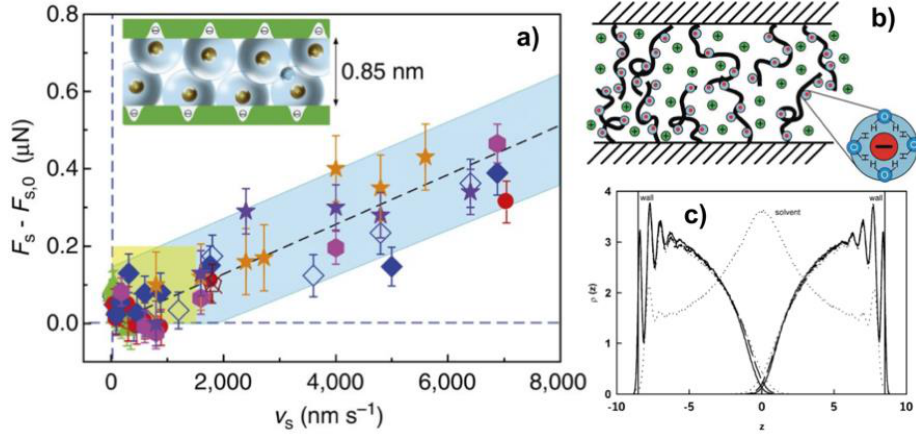
Figure 3. Origins of hydration lubrication. ( a ) The linear variation of the shear force F s with the sliding velocity ( ν s ) characterizes the viscous dissipation via a Newtonian fluid. In this example, ions with their hydration shells are confined between mica surfaces [48]. The inset is approximately to scale and illustrates the filling of the intersurface gap by the hydration water. Different symbols are from different measurements. Full and empty symbols correspond to increasing and decreasing ν s , respectively. From the slope of the blue band an effective viscosity for the confined film η eff = 0.22 ± 0.07 Pa∙s is obtained, which is ~250 times larger than the viscosity of water. This increase does not result from the confinement of water (since the viscosity remains equal to the bulk viscosity [49]) but instead the higher viscous dissipation of the hydration water is associated with the primary hydration shell surrounding the ion. Reprinted by permission from Springer Nature Customer Service Centre GmbH: Nature Research, Nature Communications, Origins of hydration lubrication, Ma, L. et al., (2015). ( b ) Cartoon representing polyelectrolyte brushes with a hydration shell. Hydration lubrication is a general mechanism that can be relevant whenever contacting hydrated species are in relative